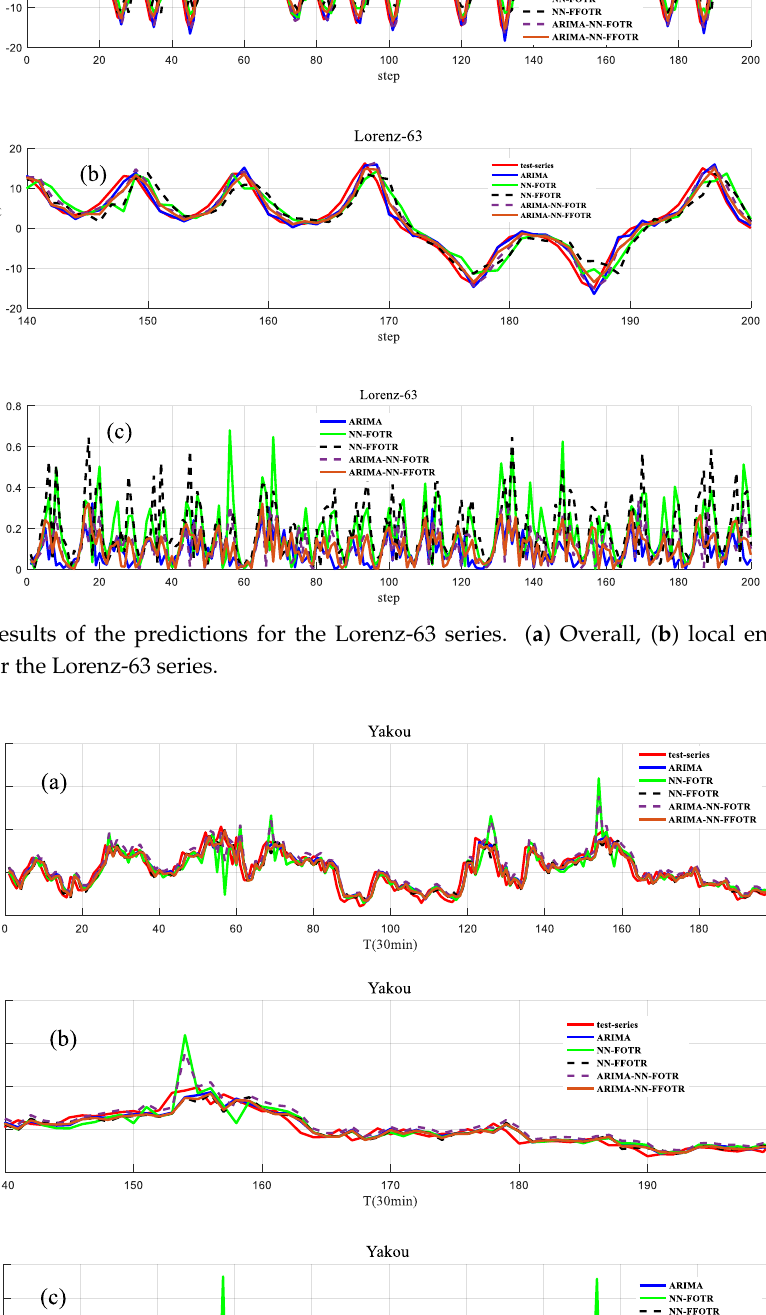
Figure 11. Results of the predictions for the wind speed at the Arou site. ( a ) Overall, ( b ) local enlargement, ( c ) RMSEs for the wind speed at the Arou site.